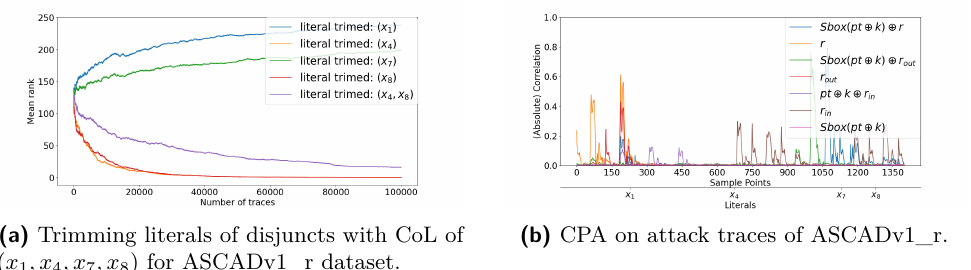
Figure 17: Guessing entropy for TTSCA big on ASCADv1_r for step 3 and CPA for